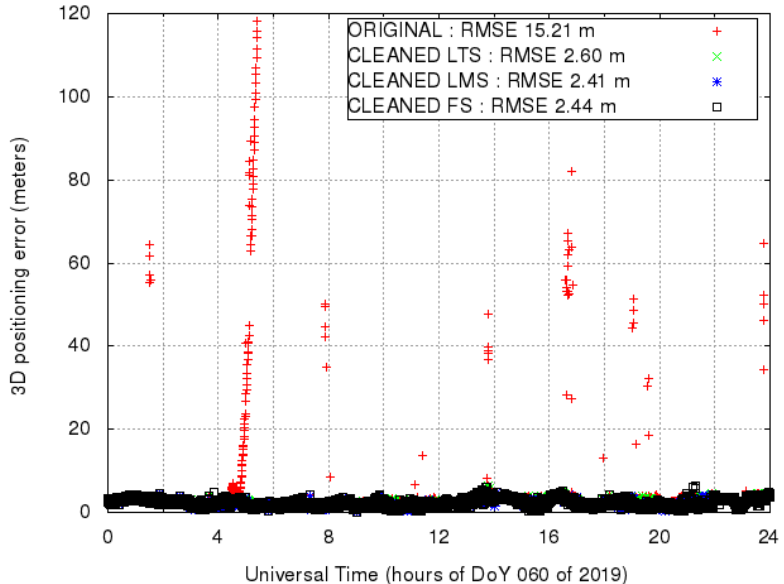
Figure 7. 3D position errors of HUEG using the SPP. In red, the original PVT obtained without detecting outliers. The PVT obtained after removing the outliers detected by LMS (blue), LTS (green) and FS (black).